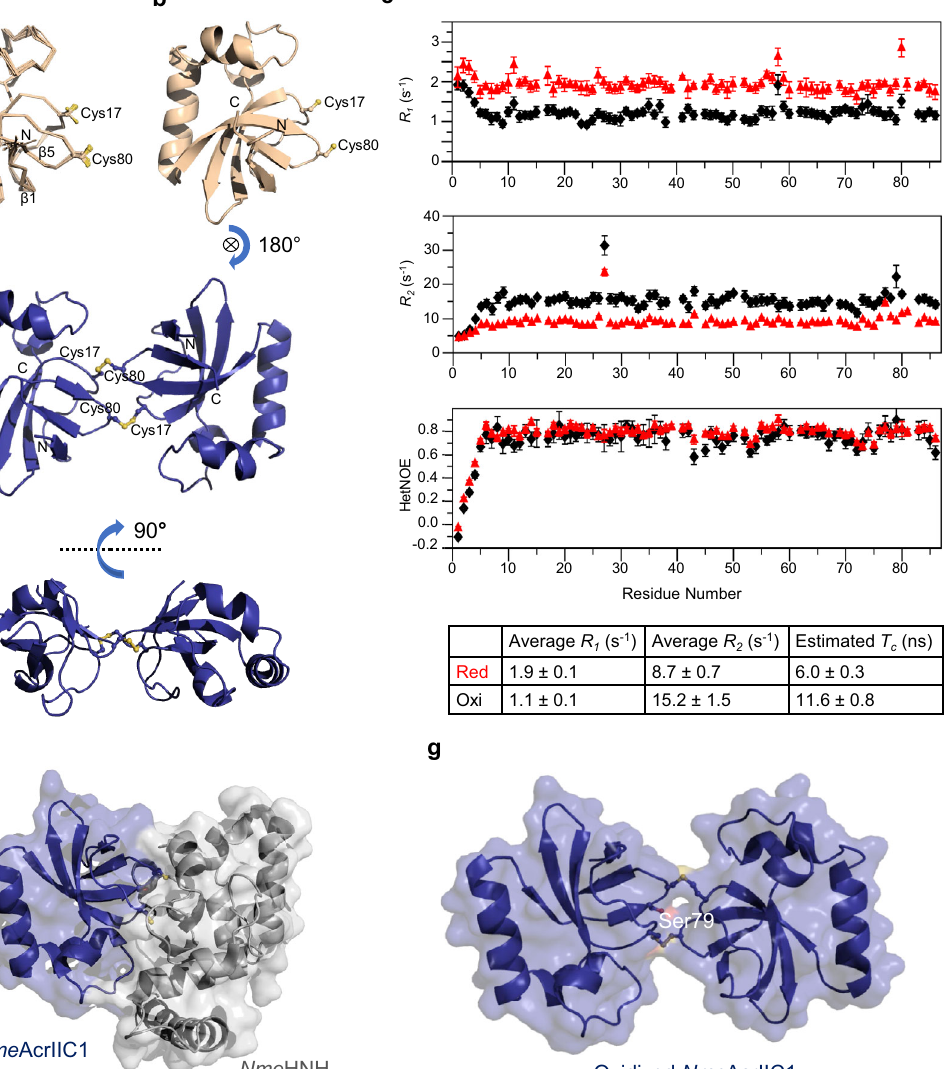
Fig. 3 | Structures and dynamics for both redox states of Nme AcrIIC1. a Superposition of the 20 lowest-energy structures of the reduced Nme AcrIIC1 calculated using solution NMR. Secondary structures are labeled, and the side chains of Cys17 and Cys80 are drawn in sticks. b The representative lowest-energy structure of the reduced Nme AcrIIC1 is shown in the ribbon diagram. c Crystal structureofthedimericoxidized Nme AcrIIC1. d Thesameas c ,rotatedby90 ° along the horizontal axis drawn in a dotted line. e 15 N backbone relaxation data for the reduced Nme AcrIIC1 (red) and the oxidized Nme AcrIIC1 (black). 15 N longitudinal relaxation rate constant R 1 (top panel), 15 N transverse relaxation rate constant R 2